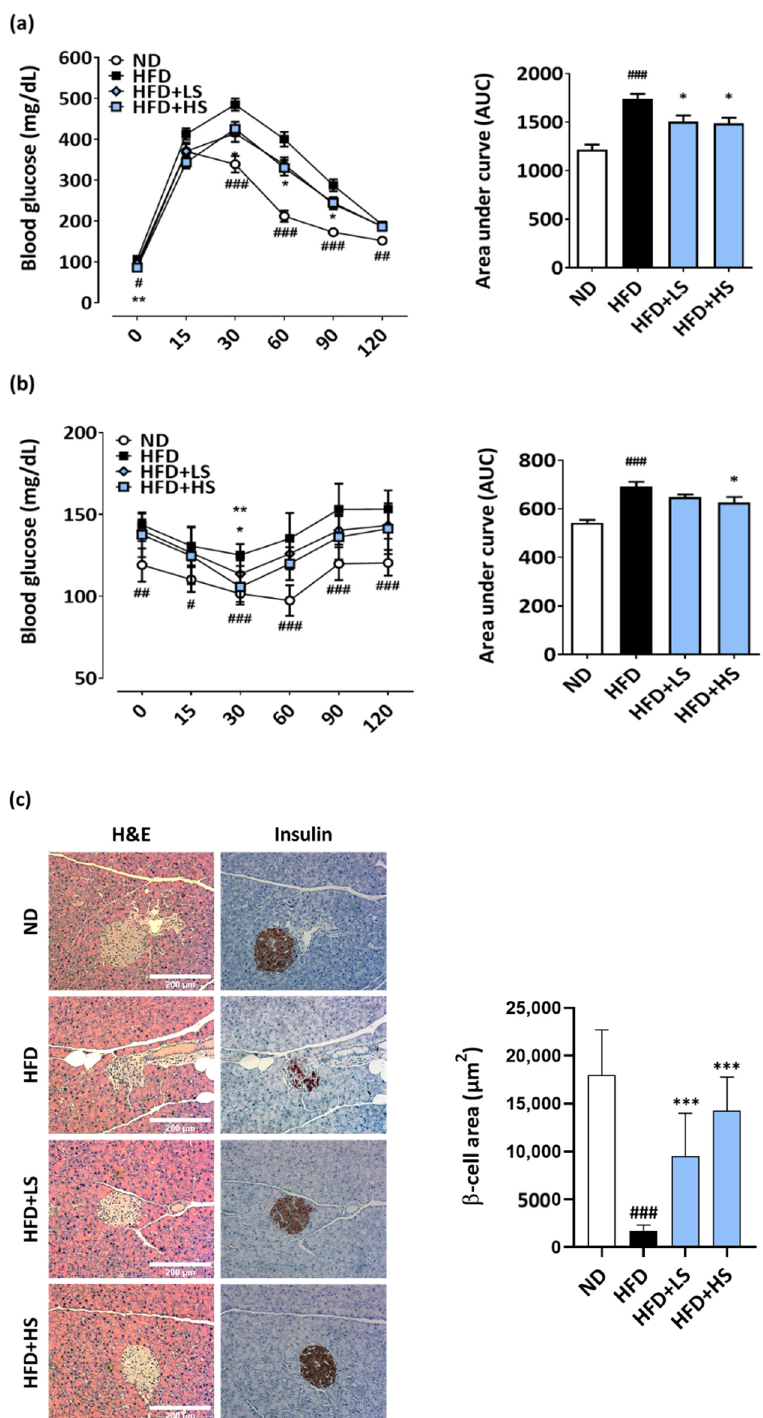
Figure 6. ME ameliorates hyperglycemia, glucose intolerance, and pancreatic β -cell mass loss in diabetic mice. ( a ) OGTT, ( b ) ipITT, and ( c ) representative images of H&E and immunohistochemistry for insulin staining (magnification 200 × , scale bar = 200 µ m). β -cell size was measured in insulin-stained sections of 8–10 islets from four mice per groups and was determined using the ImageJ software. Results are expressed as the mean ± SD ( n = 8 per group). # p < 0.05, ## p < 0.01, ### p < 0.001 versus ND group; * p < 0.05, ** p < 0.01, *** p < 0.001 versus HFD group. OGTT, oral glucose tolerance test; ipITT, intraperitoneal insulin tolerance test; ND, normal diet; HFD, high-fat diet; HFD + LS, HFD plus 0.1% ME; HFD + HS, HFD plus 0.25%